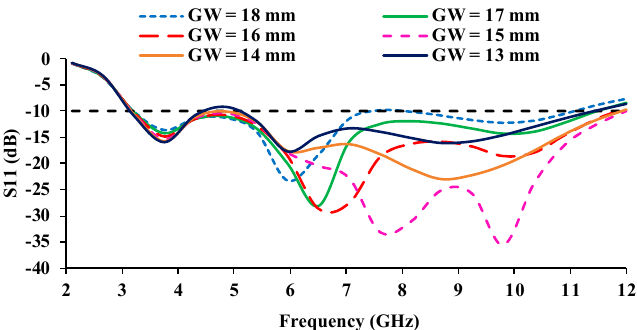
Figure 4. Parametric analysis of the antenna with varying ground plane width (GW). ( a ) GW = 18